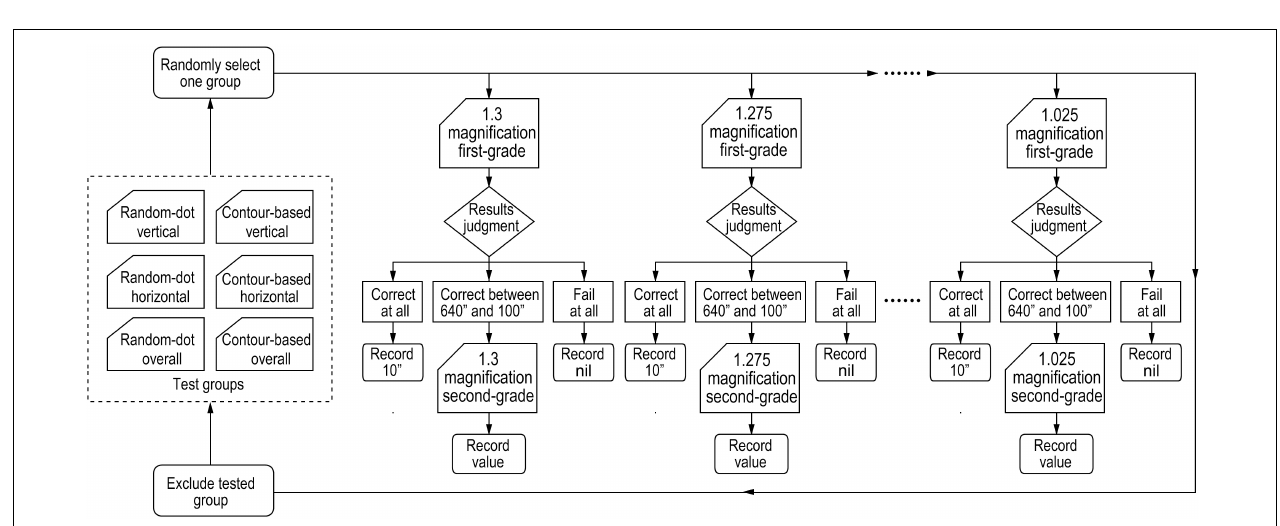
FIGURE 4 | Legend of random-dot pattern of the second grade test page (110 (cid:48)(cid:48) –180 (cid:48)(cid:48) ) with 20% induced horizontal aniseikonia. (A) Left eye image. (B) Right eye image. (C) Simulation of the perception of the test images. The disparity of the target circle was 180 (cid:48)(cid:48) , 170 (cid:48)(cid:48) , 160 (cid:48)(cid:48) , 150 (cid:48)(cid:48) , 140 (cid:48)(cid:48) , 130 (cid:48)(cid:48) , 120 (cid:48)(cid:48) , and 110 (cid:48)(cid:48) . The center of the comparison hidden circles was at the same point when fused correctly, but the size of test symbols in left eye image was enlarged by 20% in the horizontal direction to induce aniseikonia. All squares appeared to be rotated at a certain angle clockwise along the vertical axis of the screen.